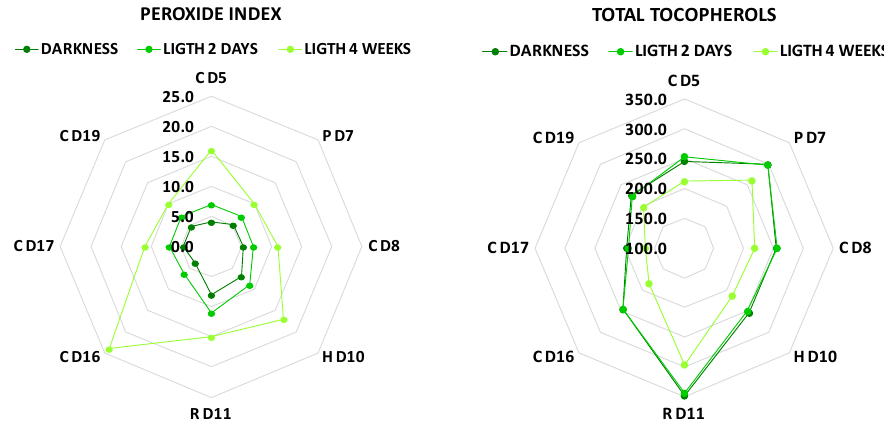
Figure 3. Radial diagrams of peroxide index and total tocopherols content for the eight original samples and the light exposure treatments.